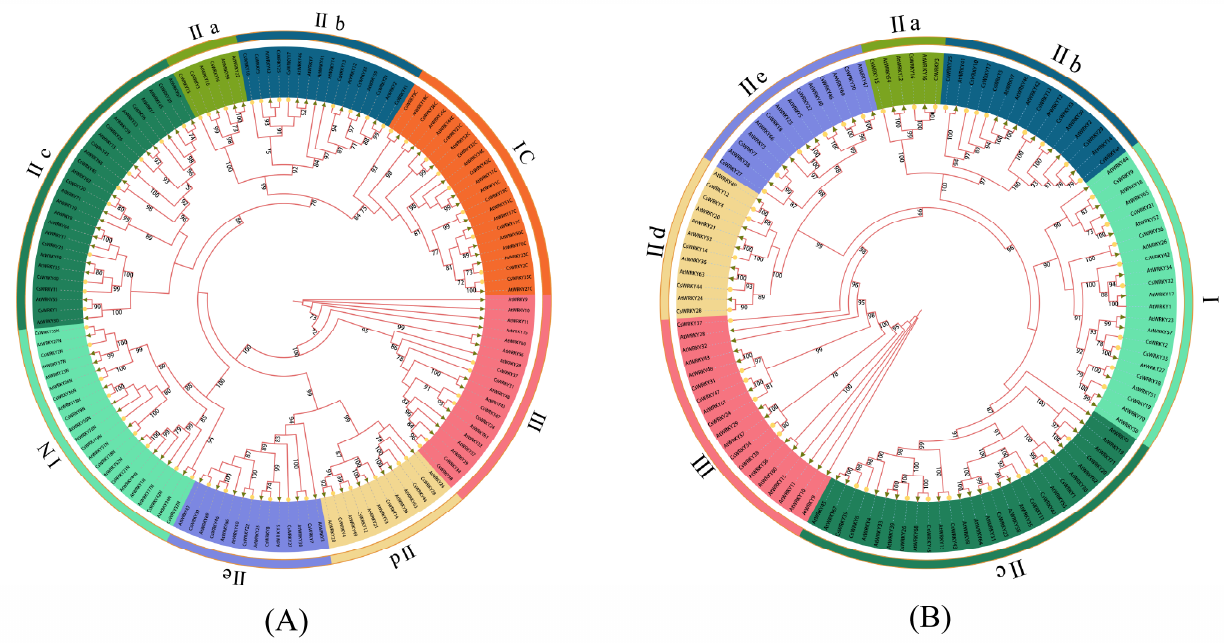
Figure 3. Rootless phylogenetic tree of CsWRKY and AtWRKY TFs. ( A ) A phylogenetic tree based on the domains of CsWRKY and AtWRKY TFs (65–69 spanning amino acid sequences) was constructed using the maximum likelihood tree-building software IQ-TREE, with the optimal model being JTTDCMut + I + G4. ( B ) The phylogenetic tree based on the full-length amino acid sequences of the CsWRKY and AtWRKY TFs was constructed using the maximum likelihood tree-building software IQ-TREE, with the optimal model JTTDCMut + F + R5. The calibration parameters bootstrap was repeated 1000 times and retouched by iTOL. Branches with bootstrap ≥ 70% were shown, unmarked branches represent bootstrap < 70%, and the outer Roman numerals indicate grouping.